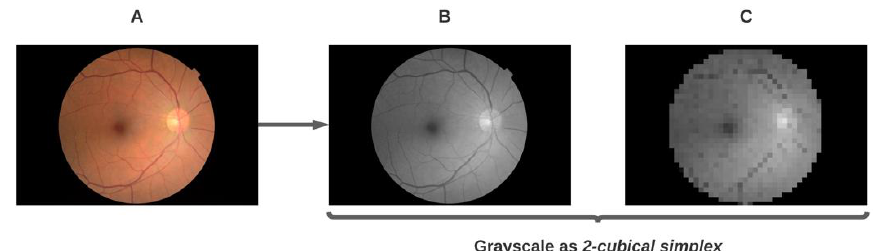
Figure 4. Example of the process of transforming a color eye fundus image from the EyePACS dataset ( A ) to the grayscale version ( B ) and a simplification to show how pixels in a grayscale image fulfill the definition of a cubical complex in 2 dimensions ( C ).